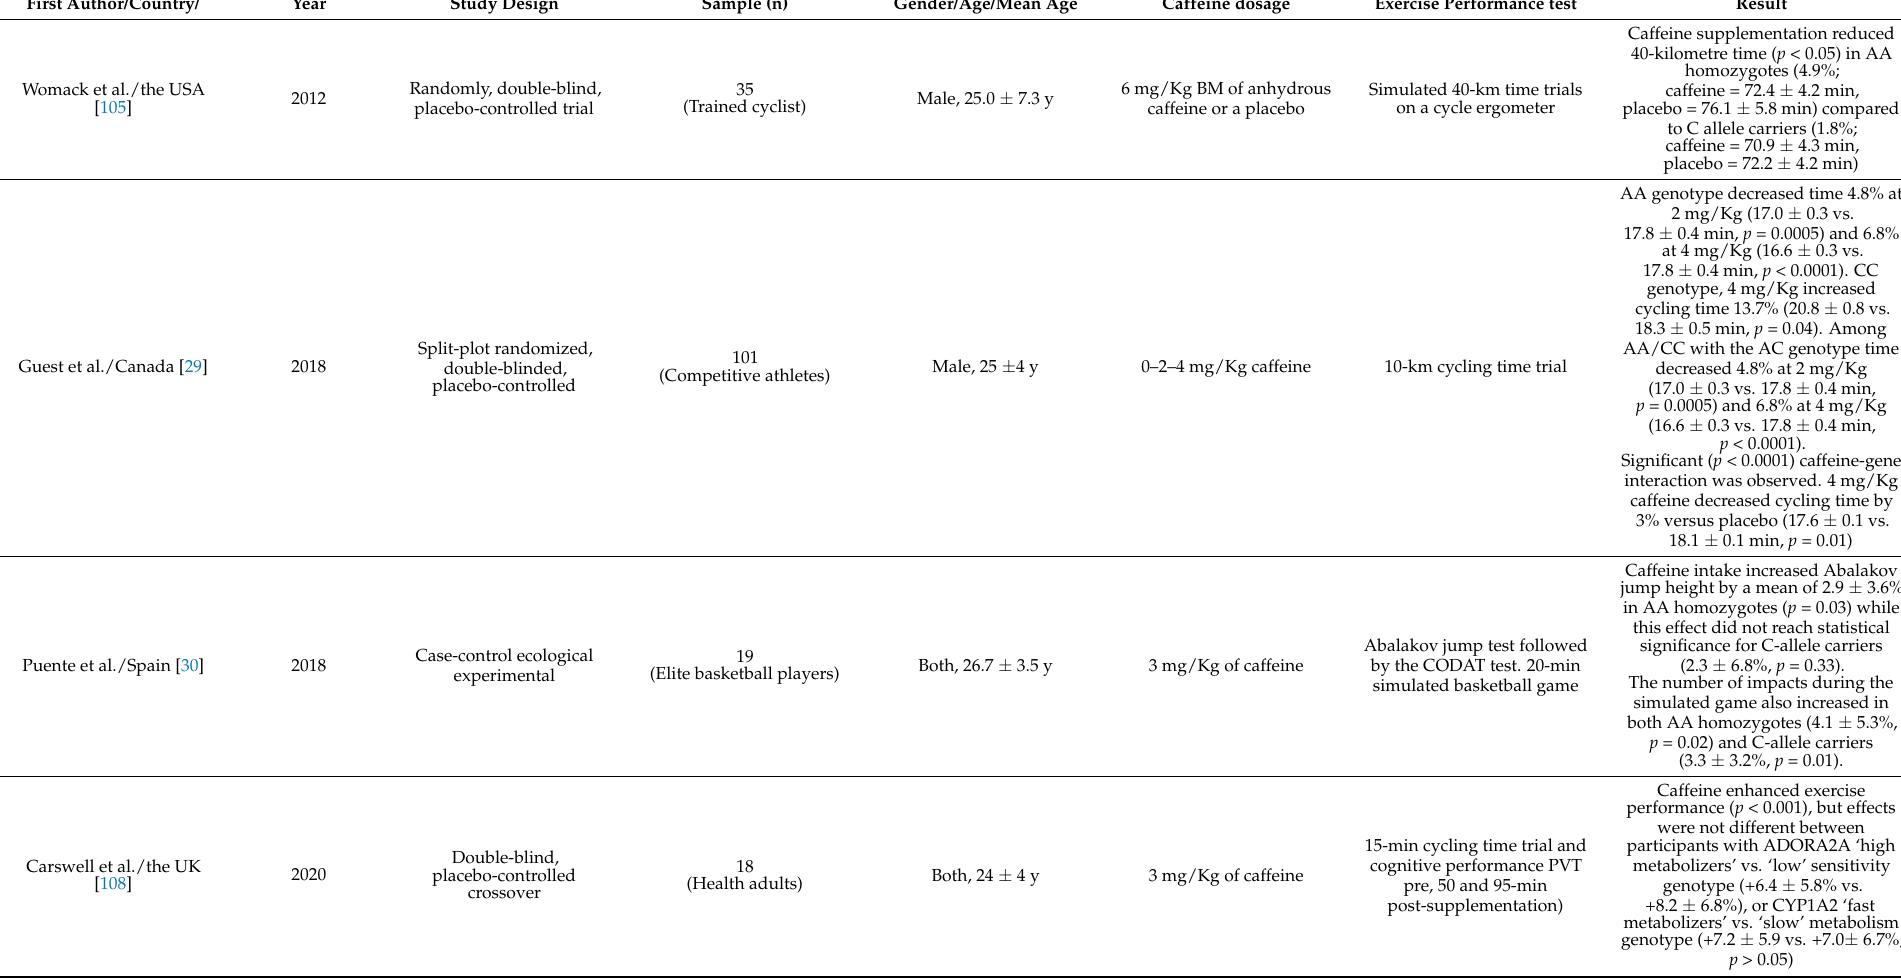
Table 2. Characteristics of studies referring to the association between energy drinks and